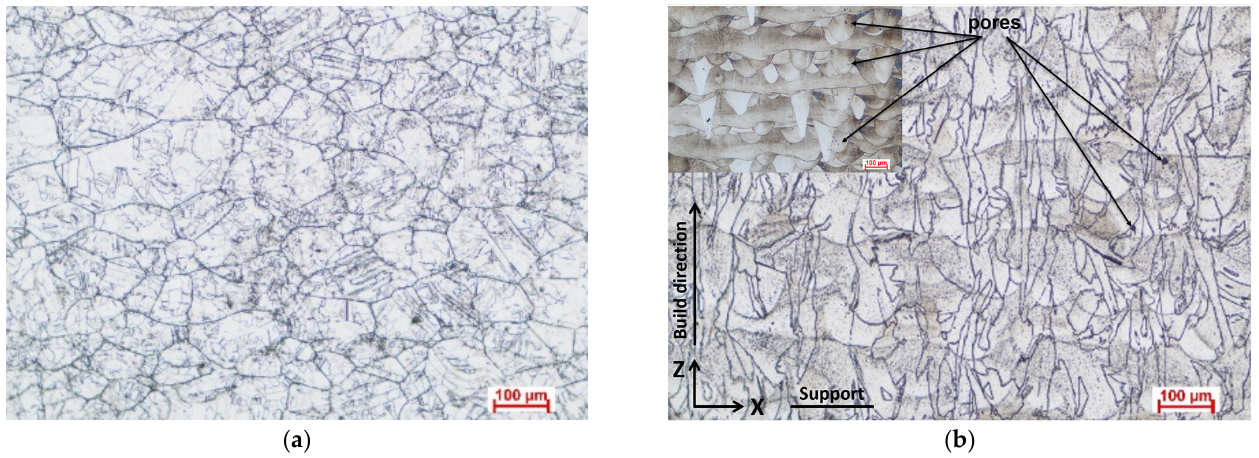
Figure 2. The microstructure of Inconel 625 for annealed AP ( a ) and 3DPP ( b ).